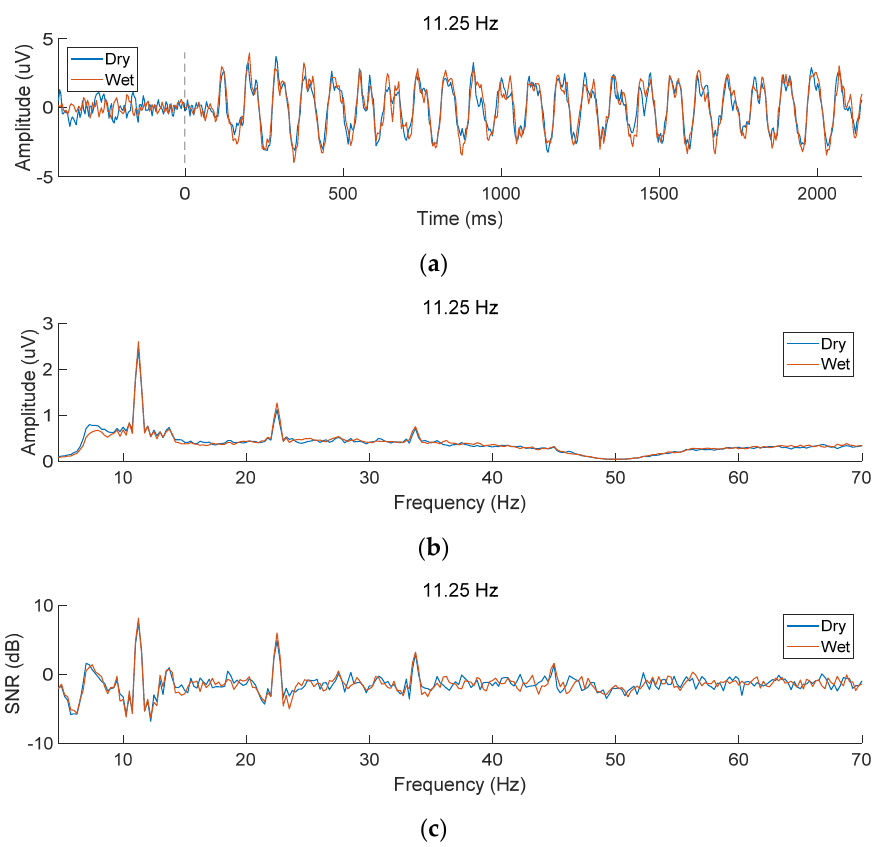
Figure 4. ( a ) Time-domain waveform, ( b ) amplitude spectrum, and ( c ) SNR of EEG signals recorded with dry and wet electrodes. SSVEPs at 11.25 Hz from the Oz channel were averaged across all subjects and all blocks. The black dashed line at horizontal axis 0 in the subfigure ( a ) represents the stimulus onset of the 2 s visual stimulation.